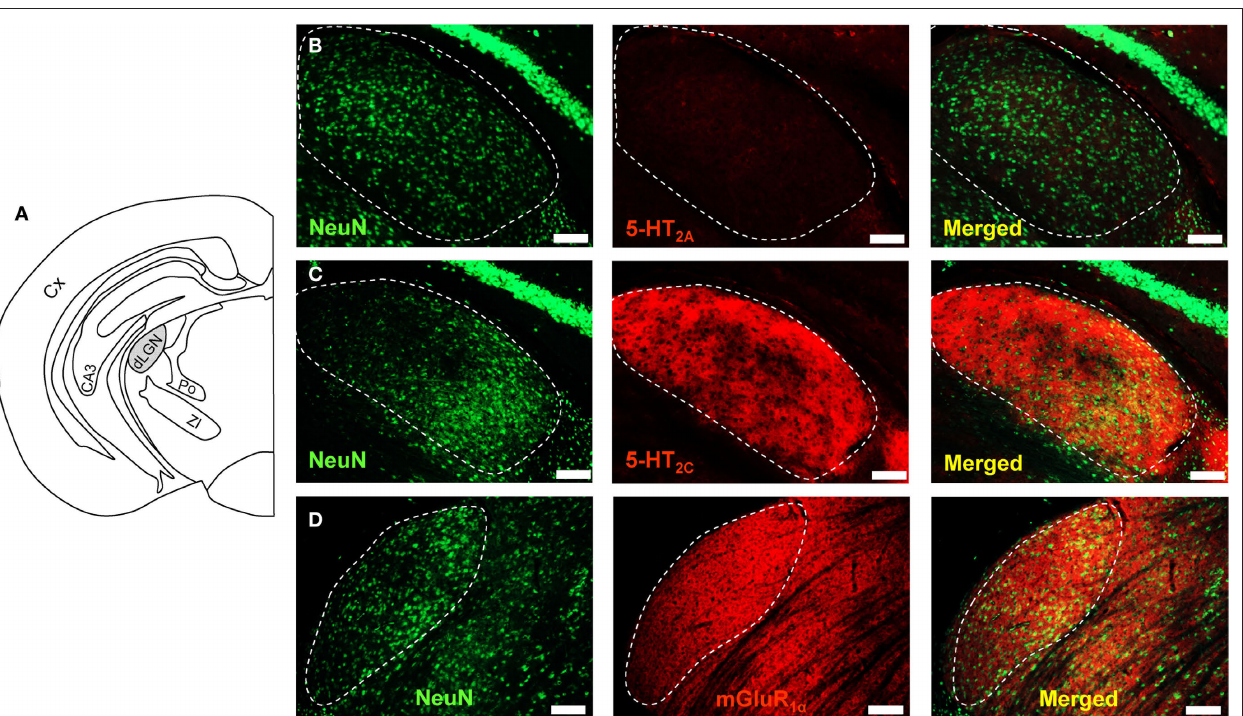
with secondary antibodies conjugated to Cy2 or Cy3. 5-HT did not cause staining (B) . 5-HT caused strong staining. 5-HT expressed. Scale bars indicate 100